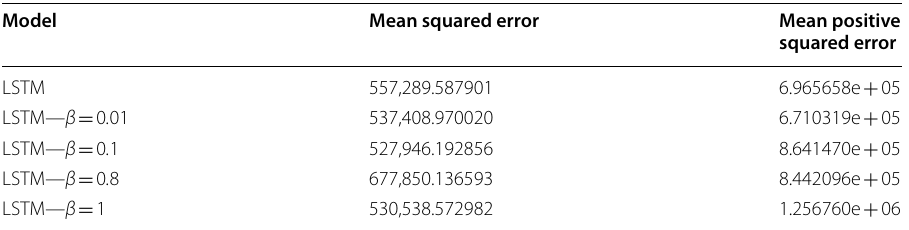
Table 1 Hyperparameter tuning in Covid-19 daily positive case study